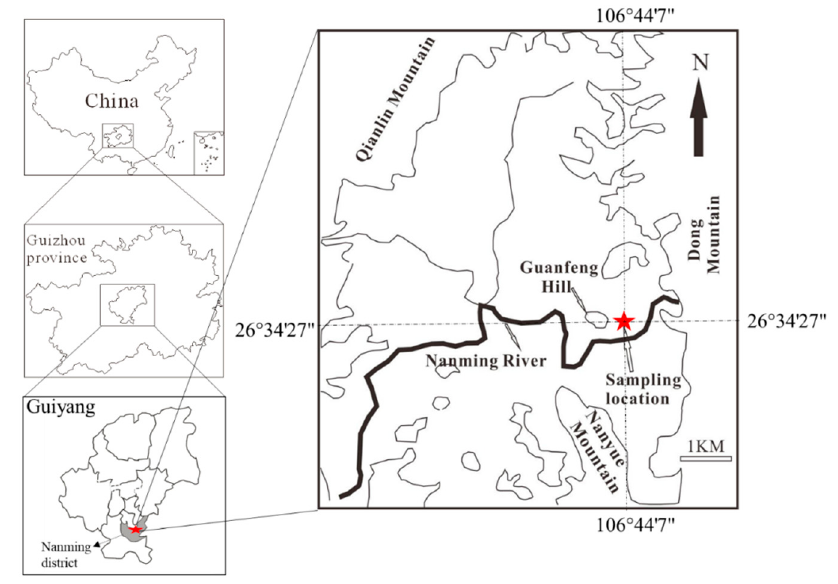
Figure 1. Map of sampling sites.